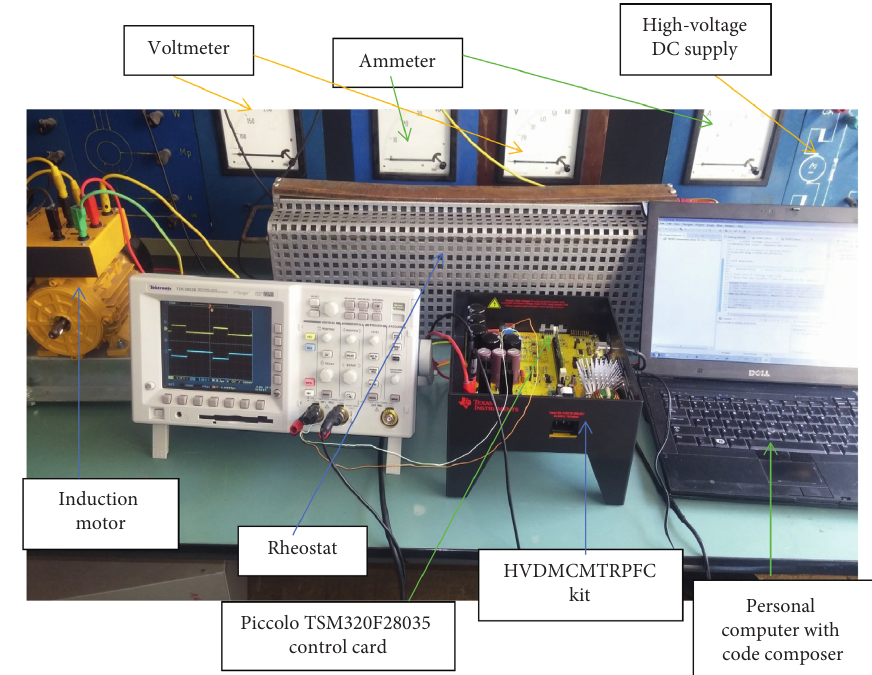
Figure 24: Experimental setup of the proposed system.